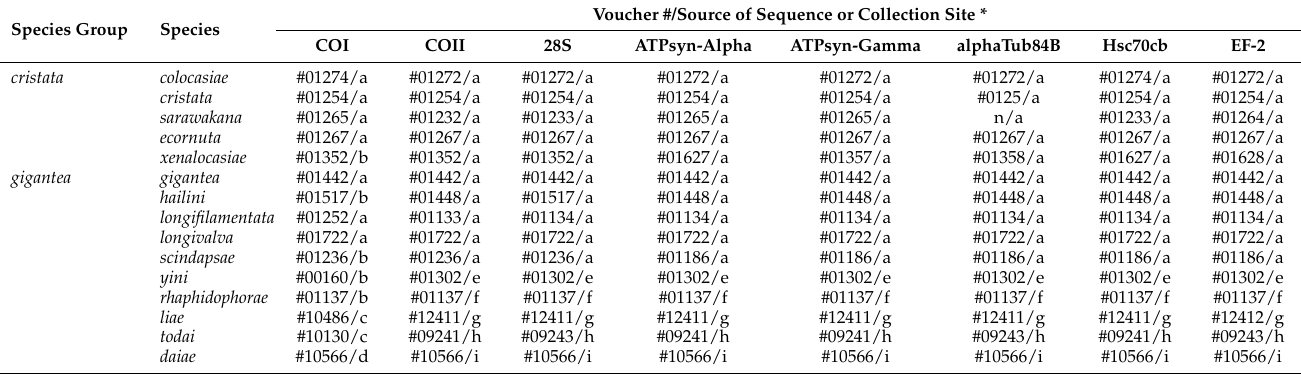
Table 1. Taxon sampling (and source of DNA sequences) in the present phylogenetic reconstruction. Voucher #/Source of Sequence or Collection Site * Species Group Species COI